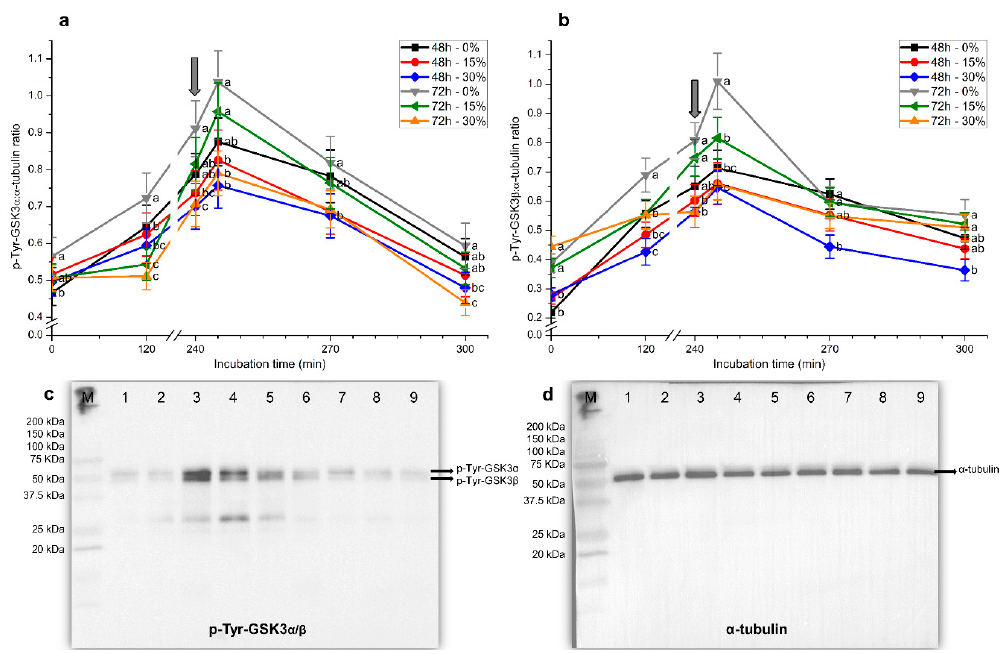
Figure 8. Relative tyrosine phosphorylation levels (using α -tubulin as a loading control) for glycogen synthase kinase-3 (GSK3) α ( a ) and GSK3 β ( b ) during in vitro capacitation and progesterone-induced acrosomal exocytosis (300 min) after previous storage of spermatozoa at 17 °C with different concentrations of seminal plasma (0%, 15%, and 30%) for 48 h or 72 h. Grey arrow indicates the time at which 10 µ g / mL progesterone was added to induce acrosomal exocytosis (i.e., 240 min). Results are shown as mean ± SEM for seven separate experiments. Different letters mean significant ( p < 0.05) differences between treatments at a given time point. Representative blots for p-Tyr-GSK3 α / β ( c ) and α -tubulin ( d ). Lanes: (M) protein ladder; (1) 72 h, 0% SP, 0 min; (2) 72 h, 0% SP, 120 min; (3) 72 h, 0% SP, 240 min; (4) 72 h, 0% SP, 245 min; (5) 72 h, 0% SP, 270 min; (6) 72 h, 0% SP, 300 min; (7) 72 h, 15% SP, 0 min; (8) 72 h, 15% SP, 120 min; (9) 72 h, 15% SP, 240